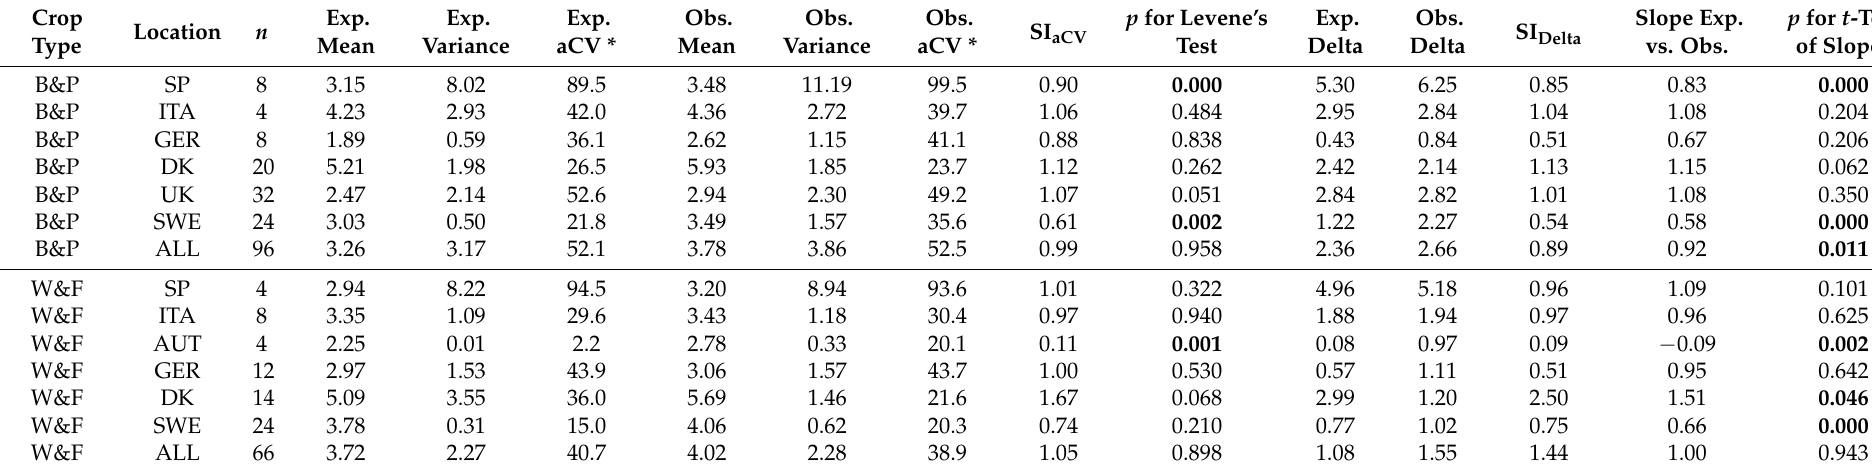
Table 2. Descriptive statistics for the crop stand-based grain yield data (Mg ha − 1 ) from barley (B) & pea (P) and wheat (W) & faba bean (F) crops grown in seven locations across Europe over two years (2017 & 2018): Expected (from sole crops) and observed (intercrops) means; the corresponding variances and adjusted coefficents of variance (aCV, %); stability indices based on aCV (SI aCV ) and the yield differences (Delta) between the two cultivation years 2017 and 2018 (SI Delta ); and the slopes for the linear regressions of expected vs. observed yields. Levene’s tests of equal variances and t -tests of slopes (cid:54) = 1 were performed on log e transformed data (significant: p < 0.050 in bold). SP Spain, ITA Italy, AUT Austria, GER Germany, DK Denmark, UK United Kingdom, SWE Sweden, ALL calculations across all sites; n indicates the number of individual cultivar combinations (plant teams) and treatments (low and high fertilization) included, for details see Table